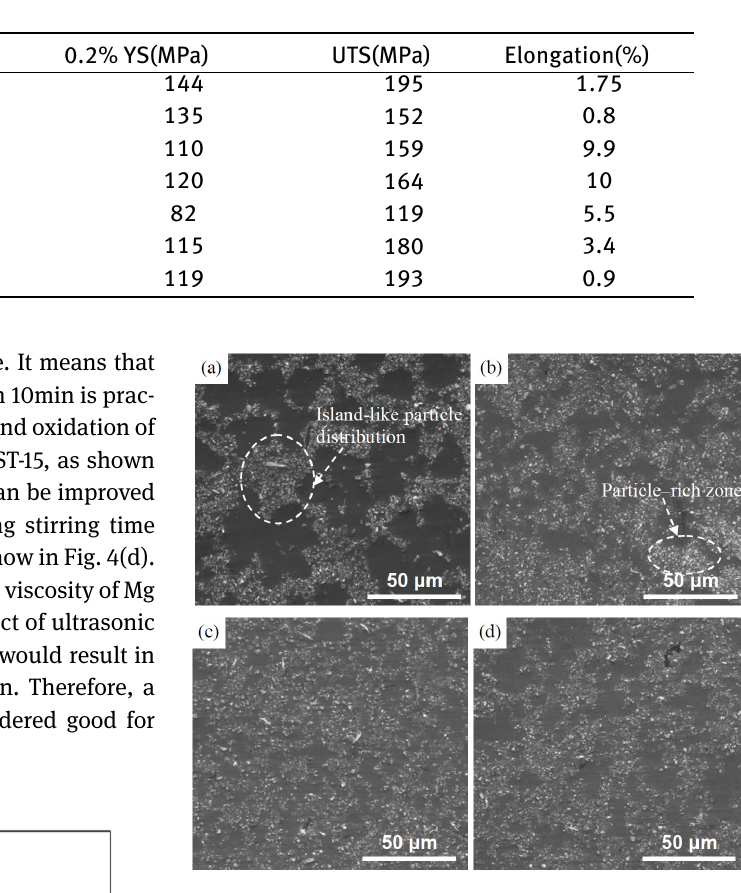
Table 2: Comparison of tensile properties of magnesium based materials